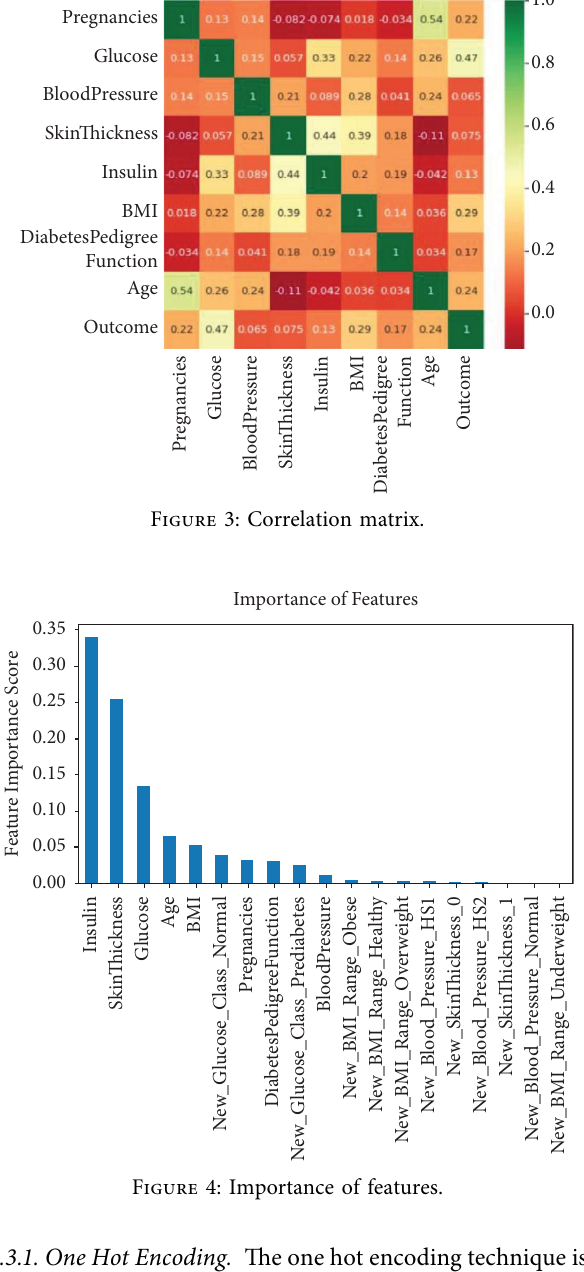
Figure 4: Importance of features.